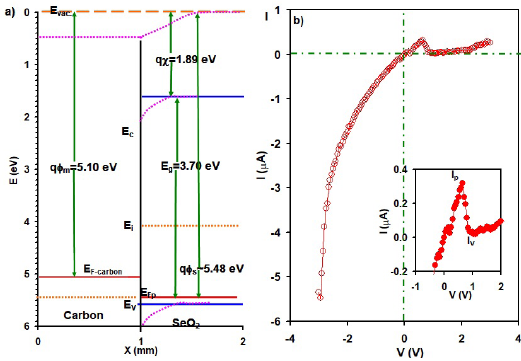
Figure 2. (a) the energy band diagram and (b) the current-voltage characteristics for Ag/SeO /C diodes. The inset of (b) shows an 2 enlargement of the forward